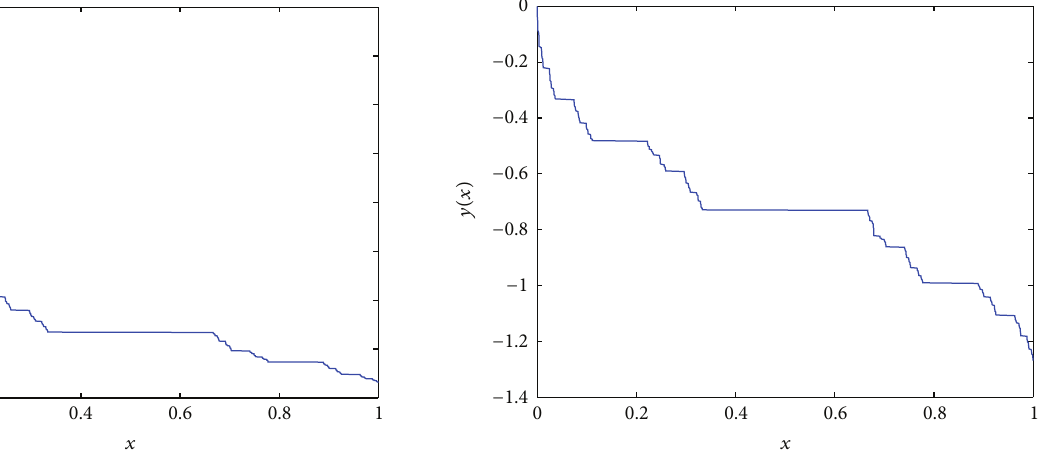
Figure 1: Graph of 𝑦(𝑥) for 𝛼 = ln 2/ ln 3 . Figure 2: Graph of 𝑦(𝑥) for 𝛼 = ln 2/ ln 3